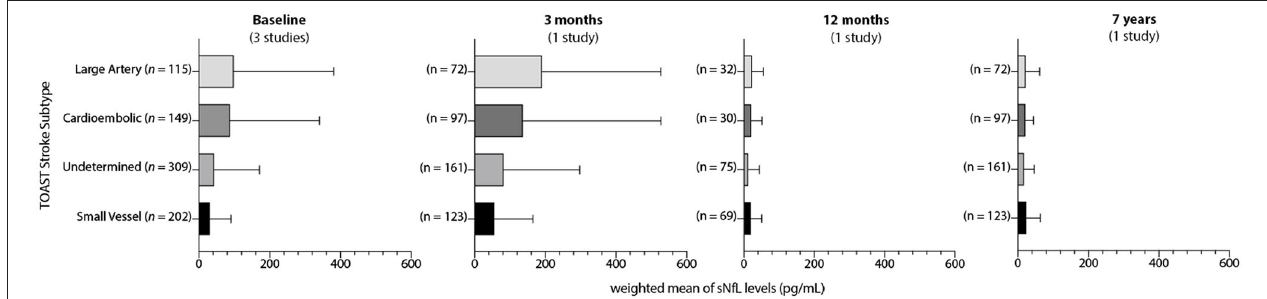
FIGURE 2 | Temporal variance in blood NfL values by acute stroke subtypes. Weighted averages of blood NfL values (pg/mL) by TOAST stroke subtype at available intervals after stroke. Error bars indicate weighted